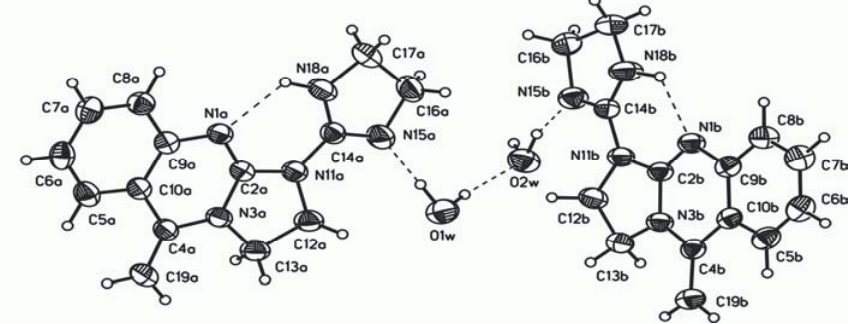
Figure 2 . ORTEP drawing showing the asymmetric part of the unit cell of 3 and atom labelling. Hydrogen bonds are shown with dashed lines. Displacement ellipsoids are drawn at 50% probability